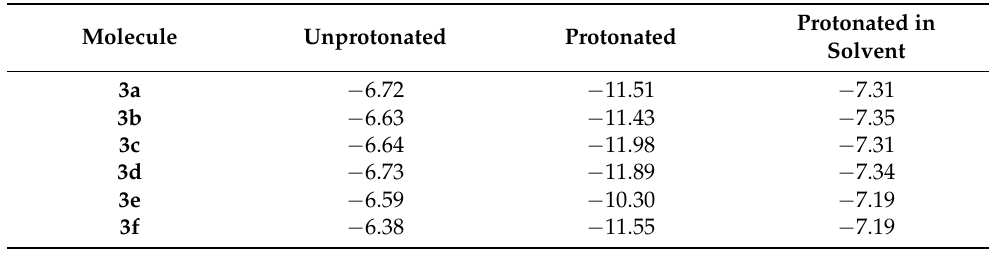
Table 7. Values for EHOMO (eV) for the inhibitors in vacuum, unprotonated, fully protonated, and fully protonated in